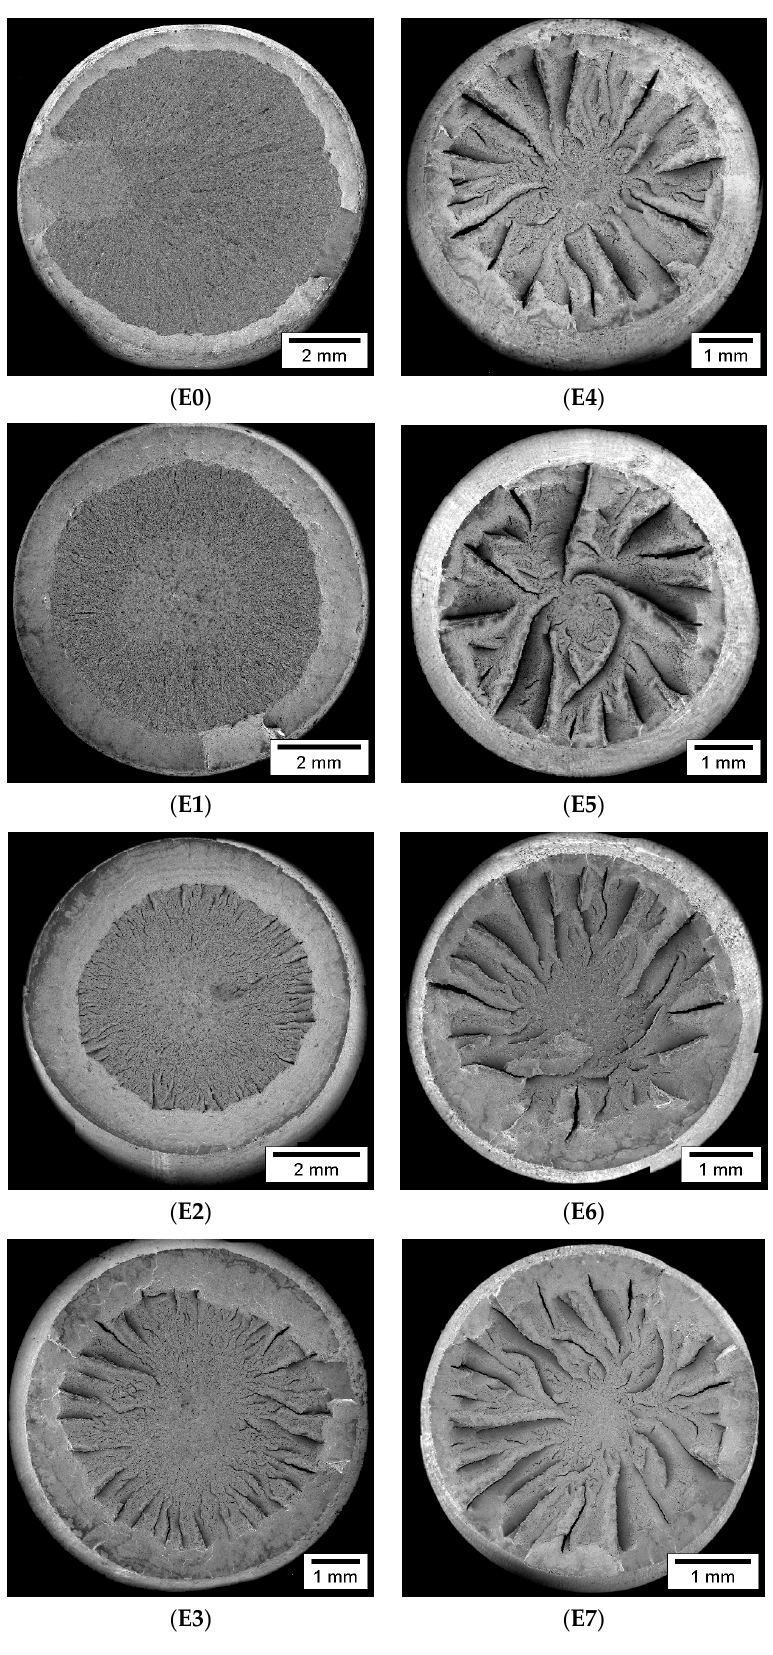
Figure 10. Evolution with drawing of MFMs of drawn wires corresponding to the family E.